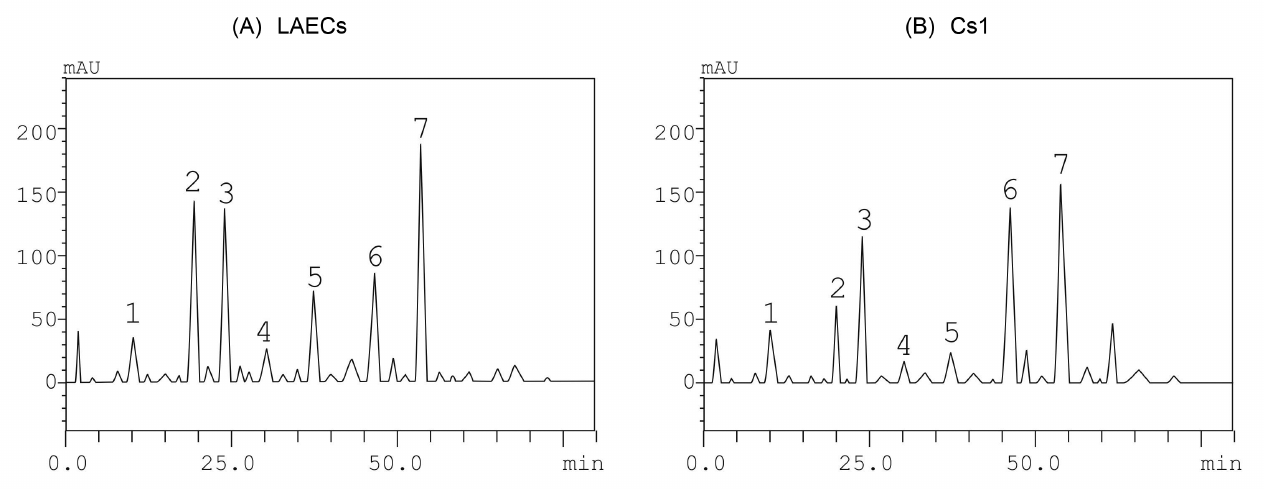
FIGURE 1 - Representative high performance liquid chromatography profiles of lyophilized aqueous extract of C. speciosa (LAECs) (A) and raw ethanol extract (Cs1) (B). UV detection at 325 nm. Gallic acid (1), chlorogenic acid (2), caffeic acid (3), ellagic acid (4), rutin (5), quercetin (6) and kaempferol